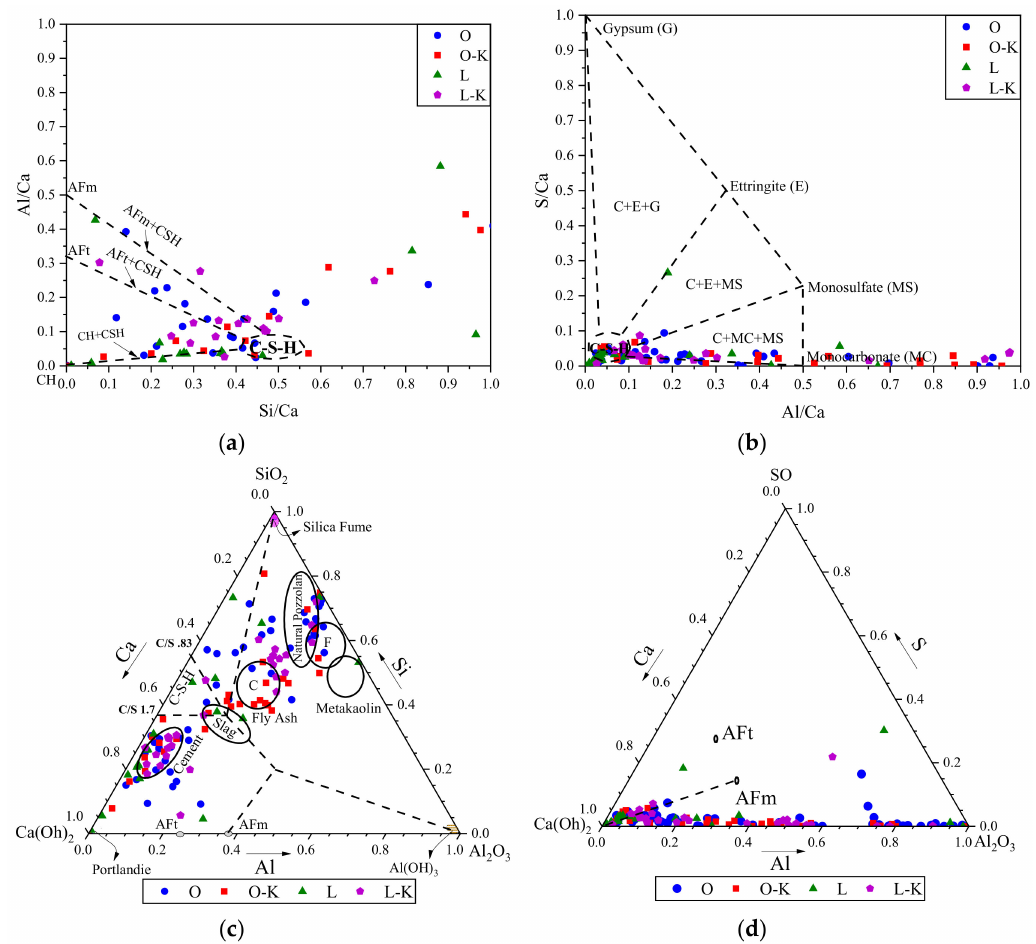
Figure 5. CWA un- / treated cementitious composites—atomic ratios of ( a ) Si / Ca vs. Al / Ca, ( b ) Al / Ca vs. S / Ca; and ternary diagrams of ( c ) Ca-Si-Al, ( d )